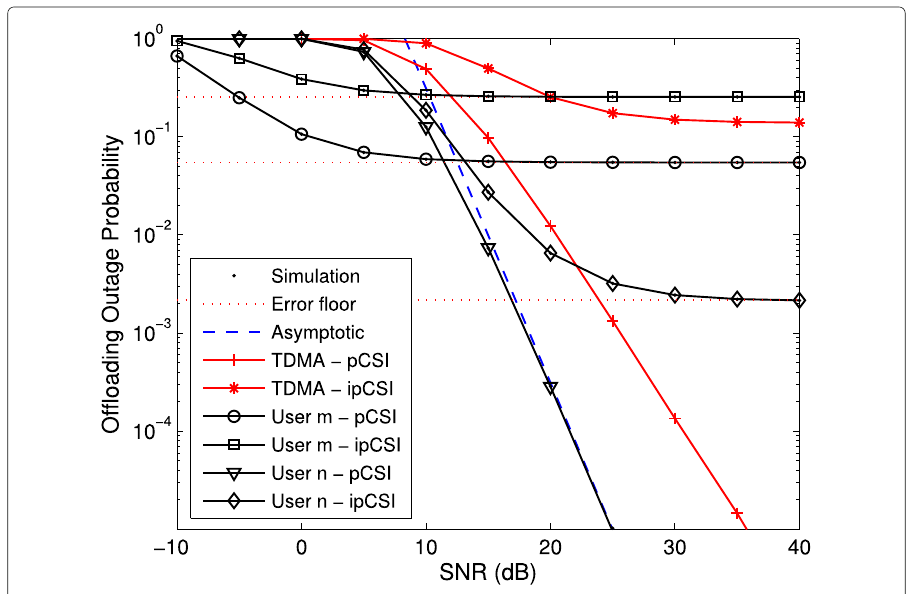
Fig. 2 Offloading outage probability for two users versus SNR